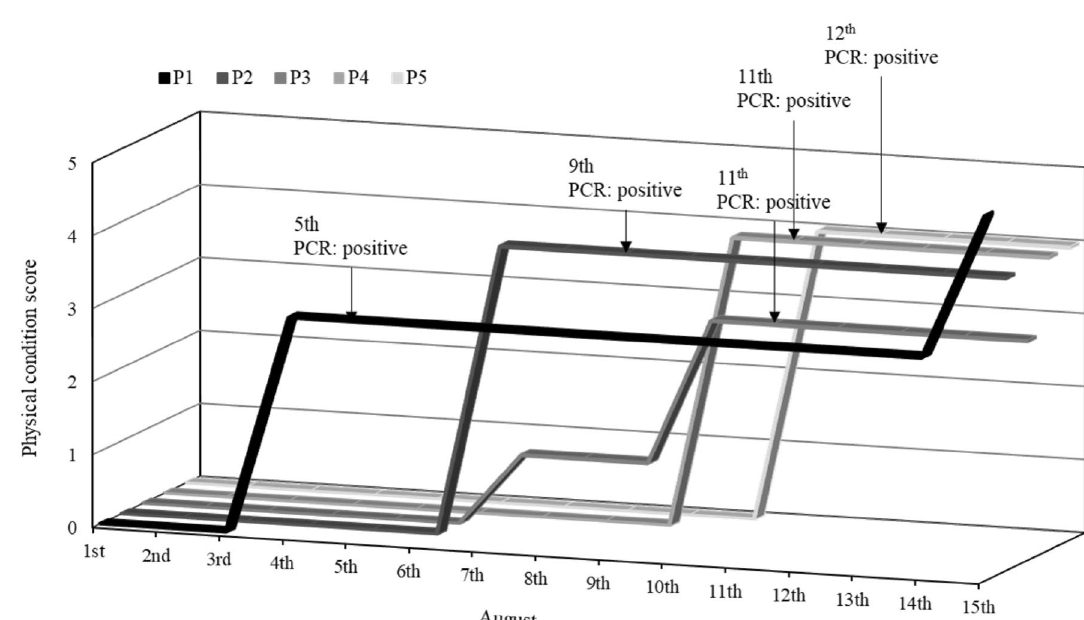
Figure 4. Change in physical condition score and time course for each